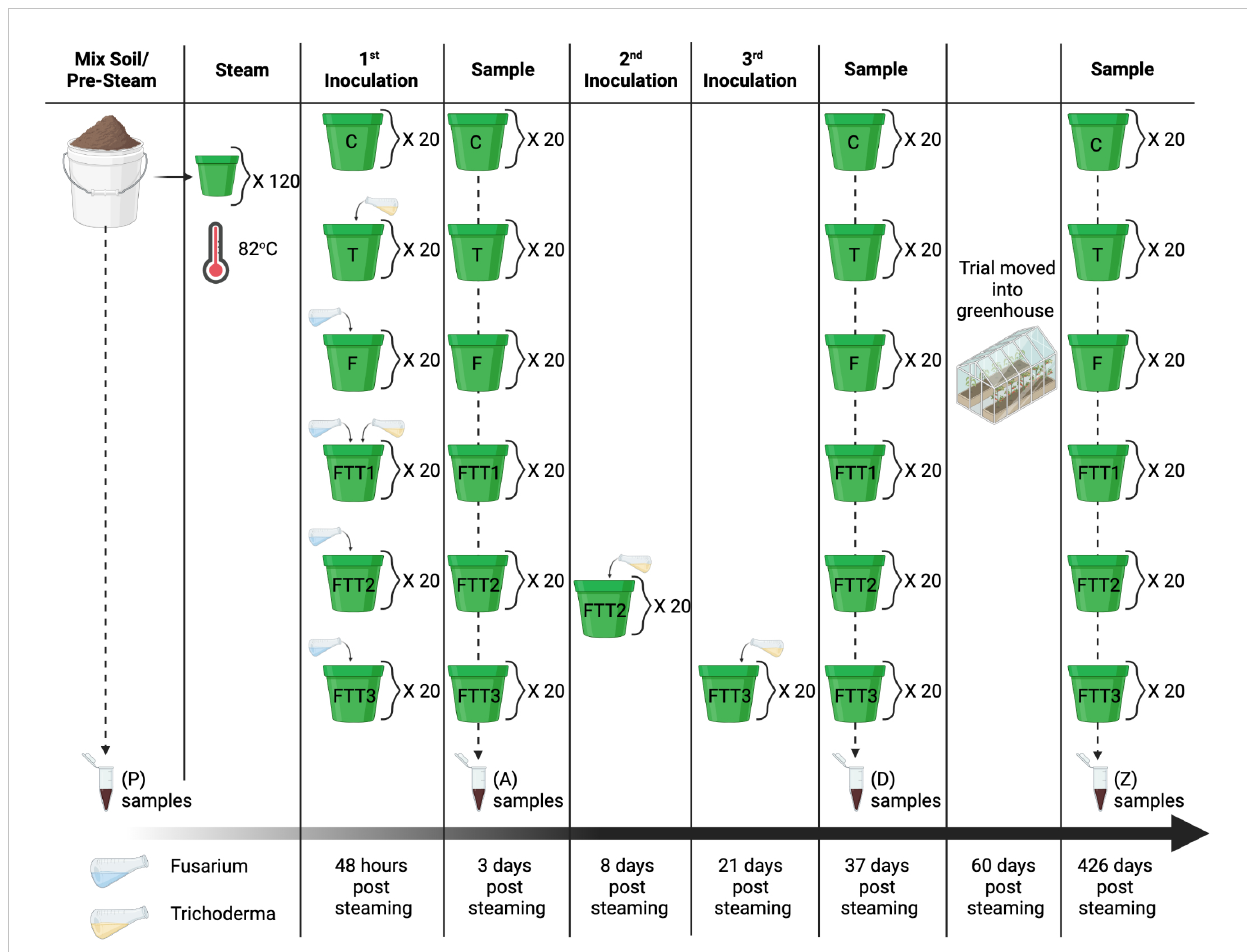
FIGURE 2 Experimental design; fi eld soil was mixed with perlite and sand and sampled at the pre-steam time point (P). The soil was distributed into 120 pots and steamed to 82°C (180°F) for one hour. The fi rst round of inoculations was applied 48 hours post steaming. The treatments were the control (C), Trichoderma (T), Fusarium (F), Fusarium Trichoderma Time 1 (FTT1), Fusarium Trichoderma Time 2 (FTT2), and Fusarium Trichoderma Time 3 (FTT3). The fi rst samples were taken 3 days post steaming. Trichoderma harzianum was added to the FTT2 replicates eight days post-steaming and to the FTT3 replicates 21 days post-steaming. The second set of samples (D) were taken 37 days post steaming. At the end of the summer the experiment was moved into a greenhouse. The last set samples (Z) were taken 426 days post